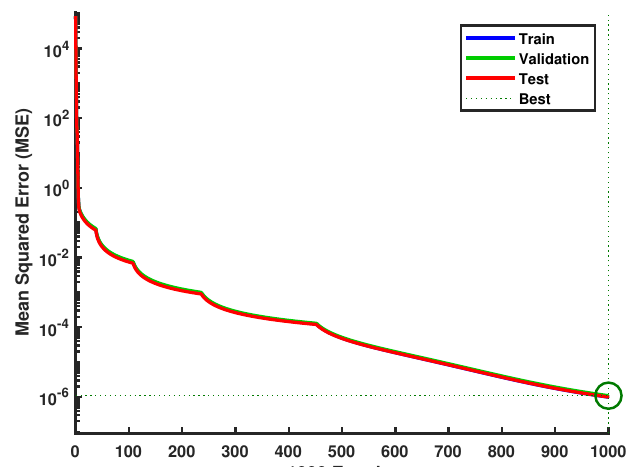
Figure 8. Mean squared error during FFNN estimation.